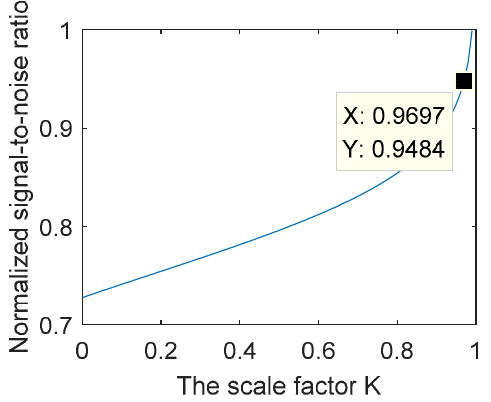
Figure 7. Influence of the scale coefficient on normalized signal-to-noise ratio.